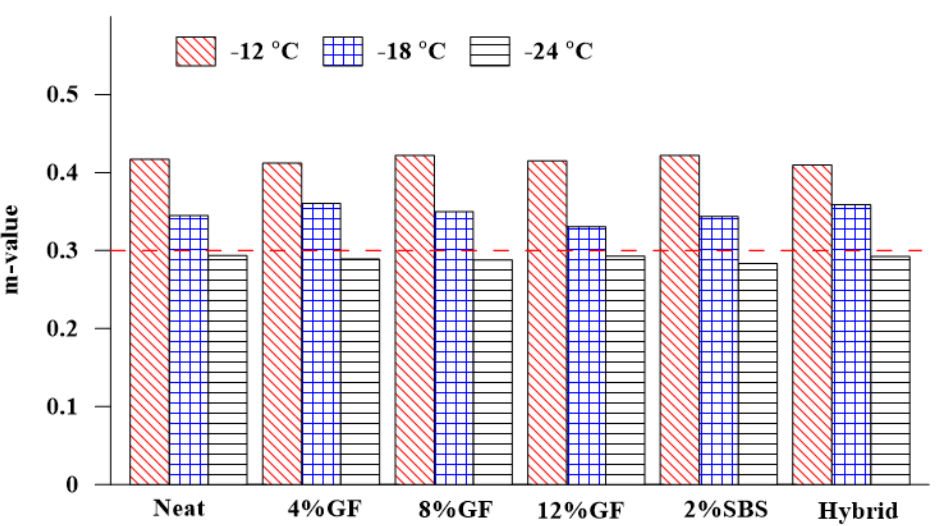
Figure 9. Effect of additives on the m